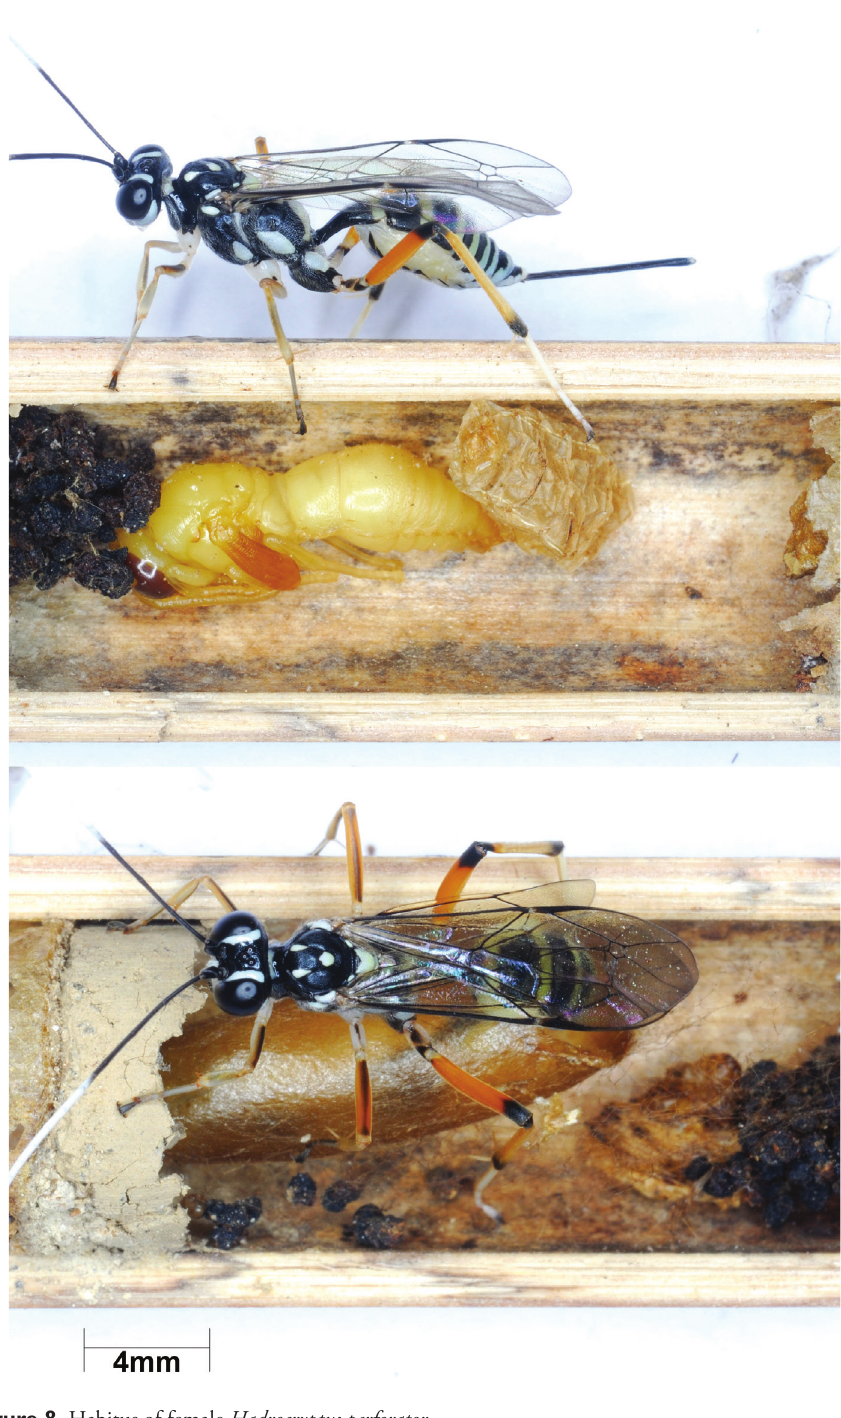
Figure 8. Habitus of female Hadrocryptus perforator